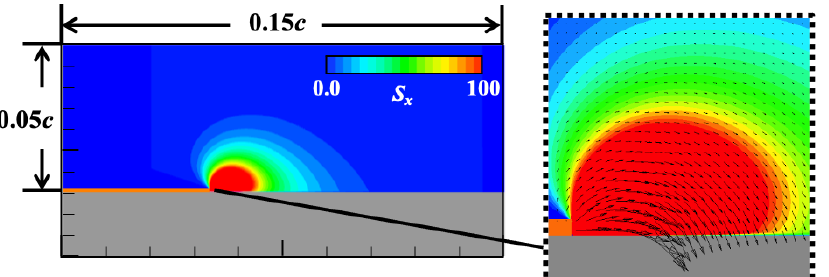
Figure 3. Distribution of body force in the x direction based on the Suzen–Huang model [34] and body force vectors near PA. Gray and orange areas represent the airfoil surface and exposed electrode,